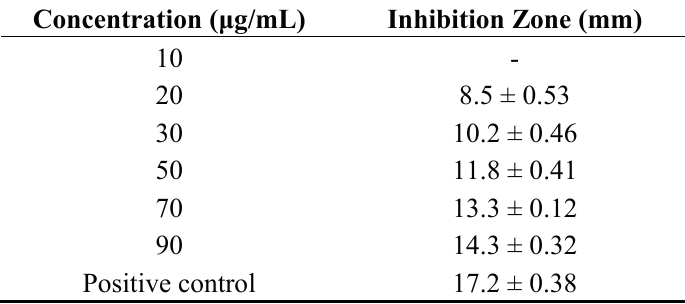
Table 1. Mean inhibition zone (mm) of biosynthesized Ag-NPs against E.coli